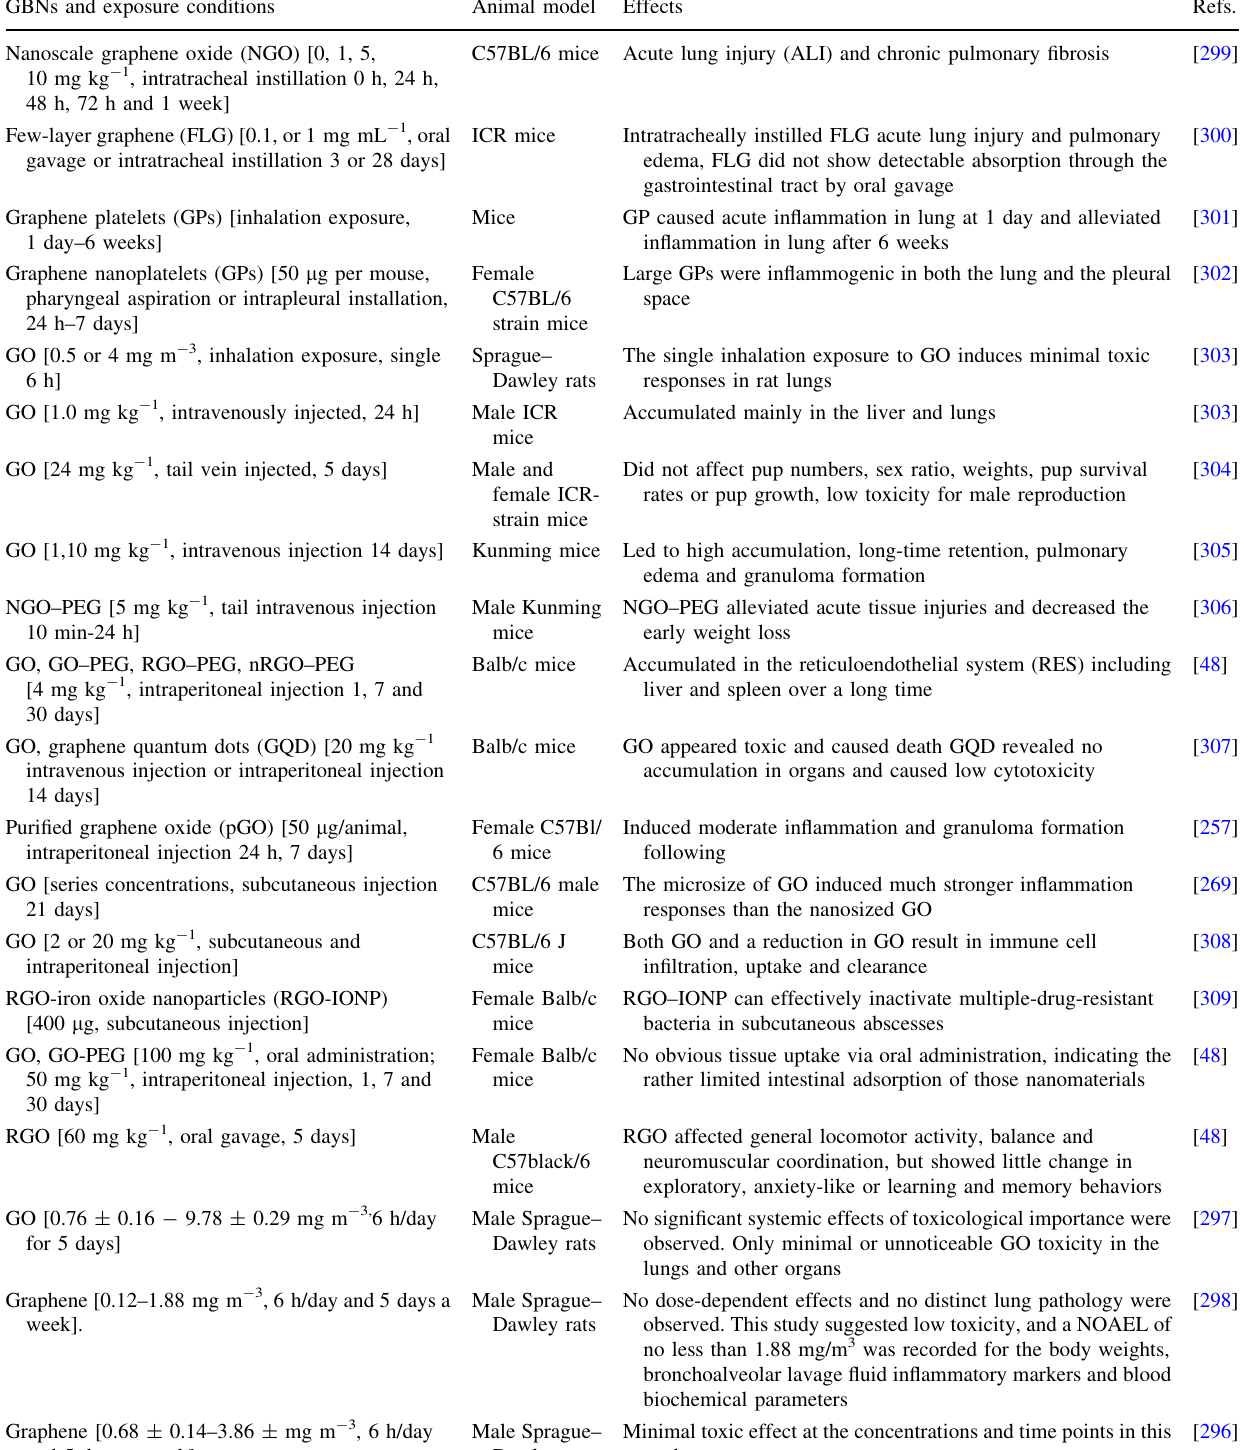
Table 6 GBNs toxicity effects in various animal models (Data adapted from [16, 296, 297, 298]) GBNs and exposure conditions Animal model